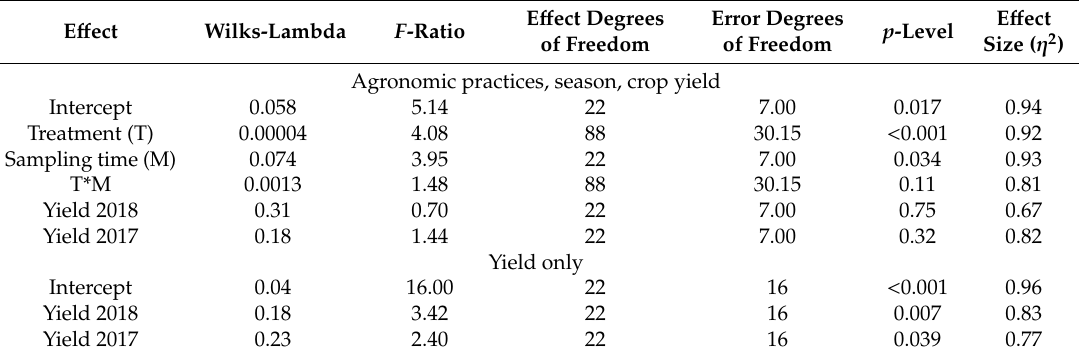
Figure 1. Total abundance (log2-transformed), taxon number, Shannon-Wiener diversity index, Pielou diversity index, and Maturity index of nematode communities (mean and 95% confidence intervals) as a response to agronomic treatments. Table 3. Multivariate GLM results examining the effect of treatment type, season and crop yield as continuous predictor on nematode assemblage composition.